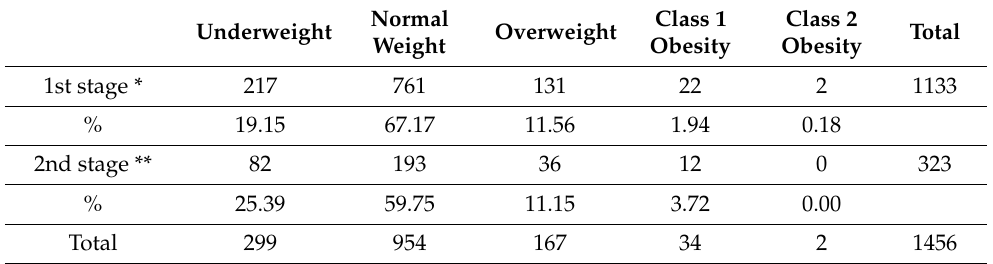
Table 2. Breakdown of pupils into categories by BMI before and after COVID-19 situation. Class 1 Class 2 Normal Total Overweight Underweight Obesity Obesity Weight 1st stage * 217 761 131 22 2 1133 % 19.15 67.17 11.56 1.94 0.18 2nd stage ** 82 193 36 12 0 323 % 25.39 59.75